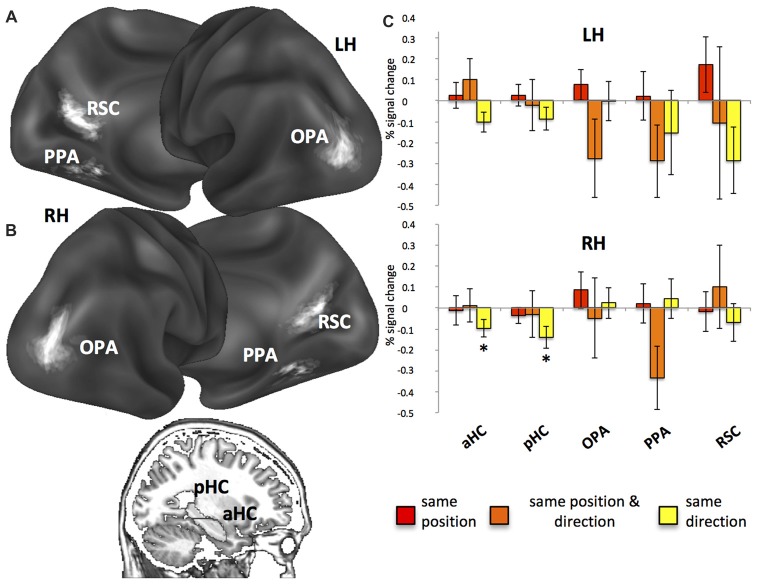
Regions of interest (ROI) and fMR adaptation. (A) Anatomical localization of the occipital place area (OPA), parahippocampal place area (PPA) and retrosplenial complex (RSC) on lateral and medial/inferior views of the cortical surface of the left (LH) and right (RH) hemispheres. (B) Anatomical localization of the anterior (aHC) and posterior hippocampus (pHC) for one sagittal slice. (C) Plots show position- and direction-related adaptation effects, i.e., reduction of estimated BOLD signal in same position, same direction and same position & direction trials as compared to all-different trials. *p < 0.05.